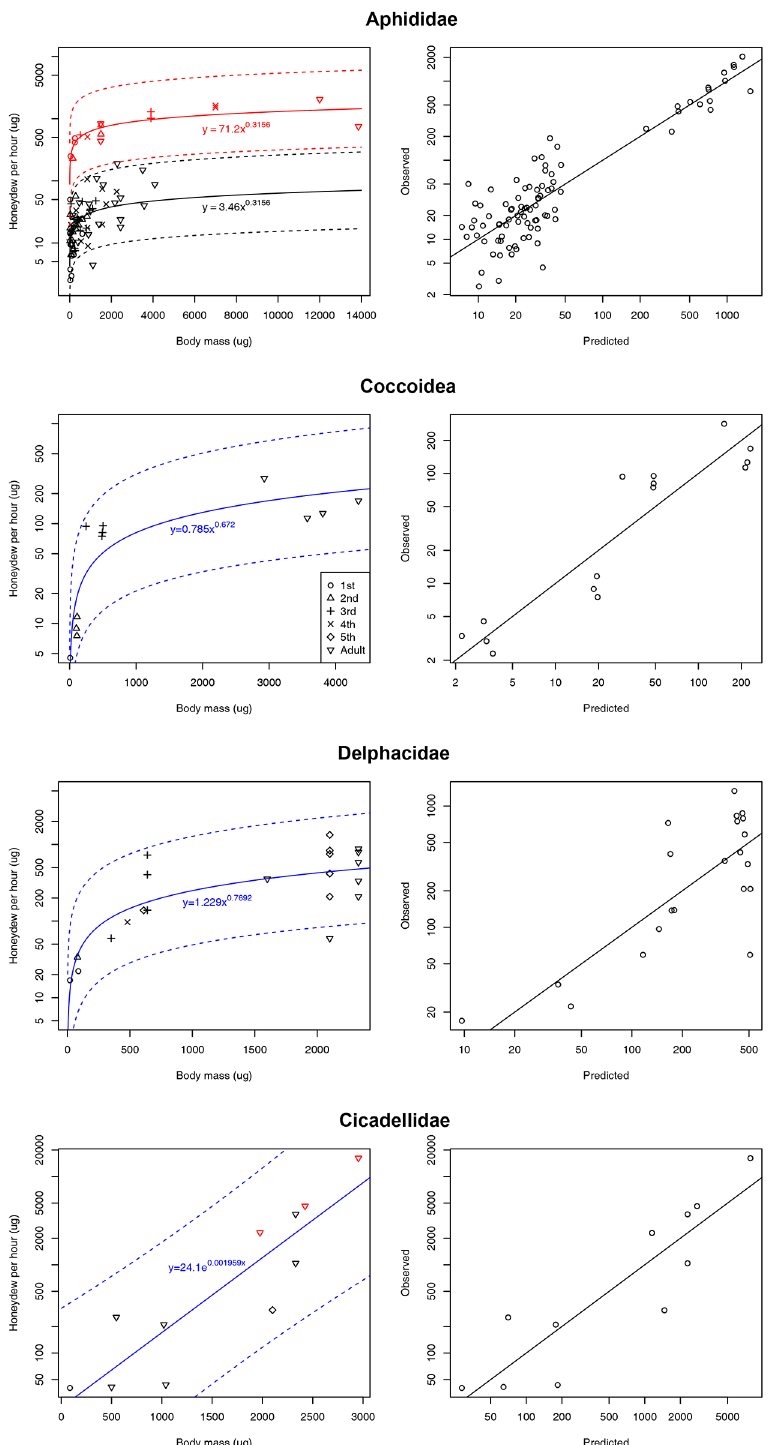
Fig 1. Empirical data for honeydew production per hour (on log scale), together with the model of best fit, for Aphididae (power-law), Coccoidea (power-law), Delphacidae (power-law), and Cicadellidae (exponential), showing actual values (symbols), model prediction (solid line) and 95% prediction interval (dashed lines). Symbols of life stage are as follows: circle—1 st instar nymphs, triangle—2 nd instar, plus symbol—3 rd instar, cross—4 th instar, diamond—5 th instar, upside down triangle—adults. Also shown for each family is the results of